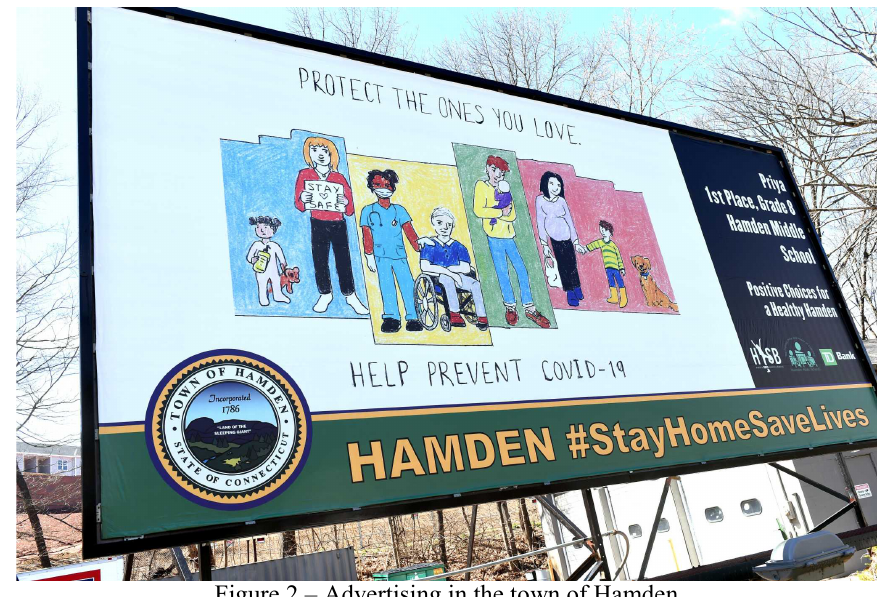
Figure 2 – Advertising in the town of Hamden